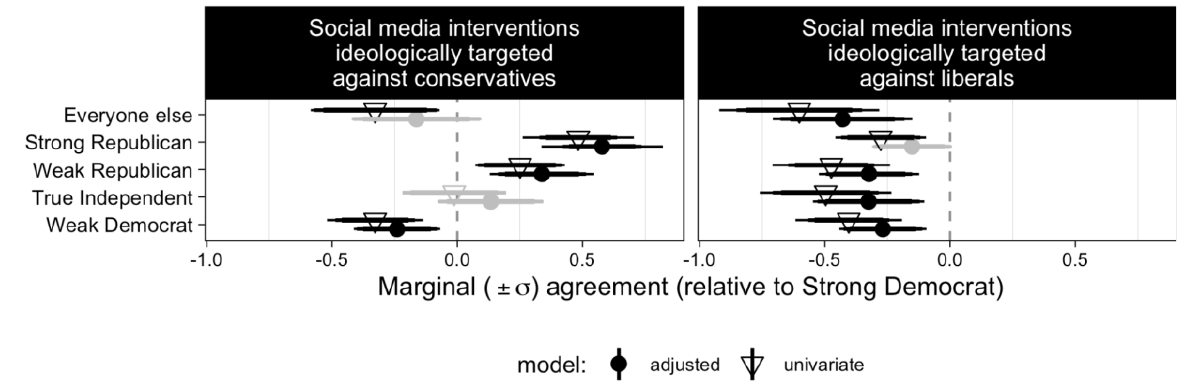
Figure 1. Association between partisanship and perception of ideological bias. This plot reinforces a finding in the main text that Republicans are explicitly more likely to think interventions are biased against conservatives than Democrats (and even "eve ryone else”). Just as most groups perceive more biased judgment in credibility labeling, most groups also agree that interventions are not ideologically targeting liberal content (right